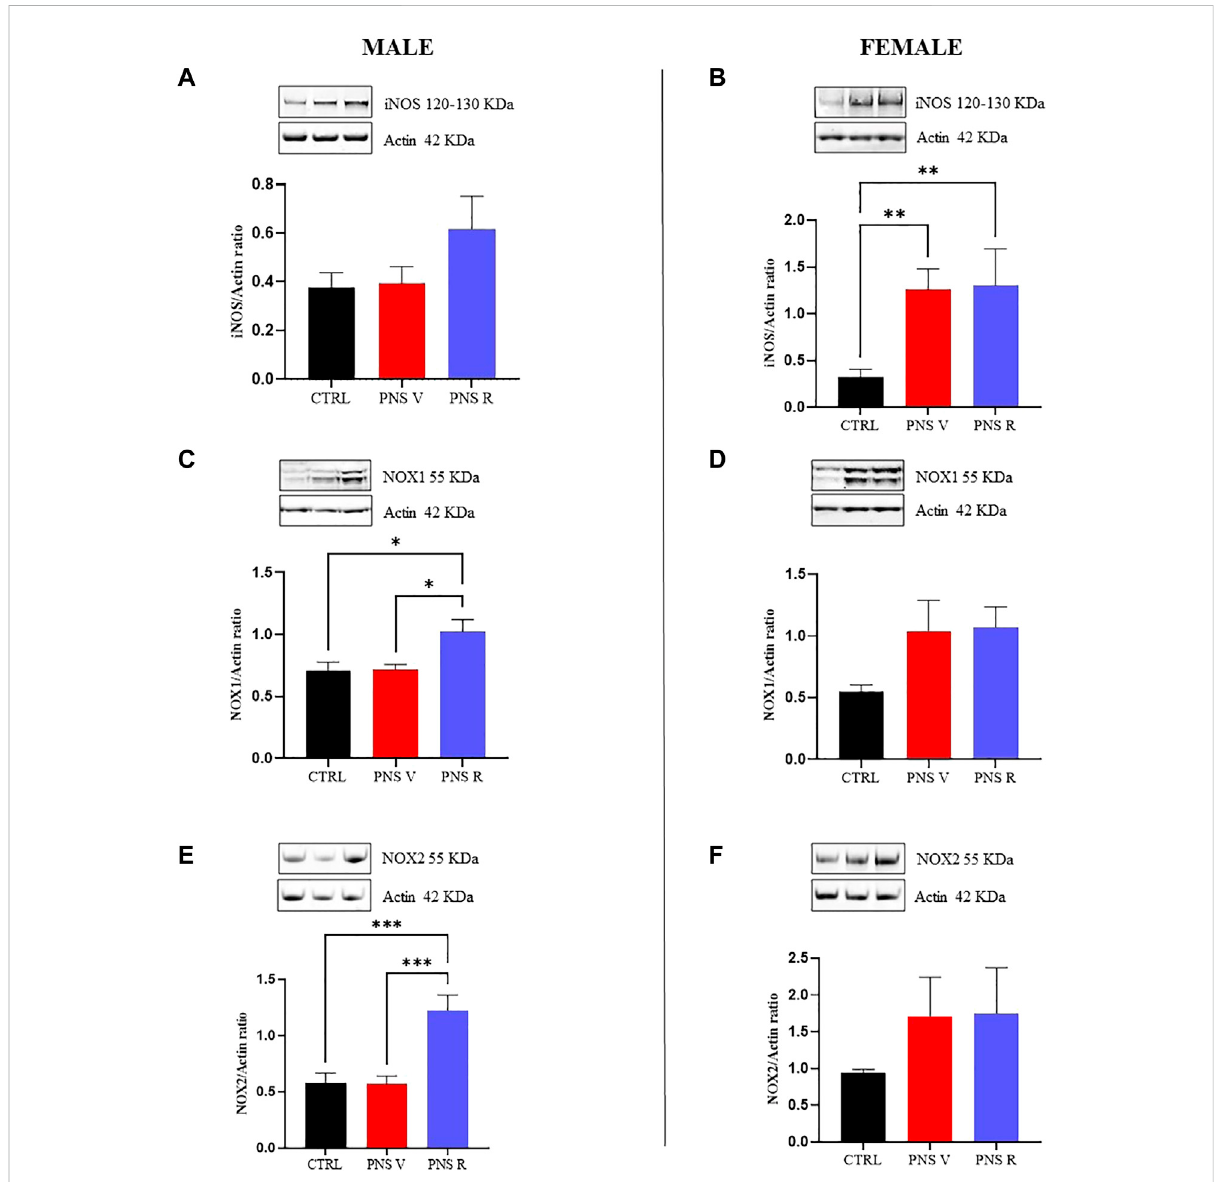
Oxidative stress response in vulnerable and resilient PNS rats. Effects induced by PNS exposure on iNOS, NOX1, and NOX2 expression in total protein extracts from hippocampus of CTRL and PNS rats evaluated by Western Blot analysis. Representative immunoblots and histograms of iNOS (120 kDa – 130 kDa) in CTRL and PNS male (A) and female (B) adolescent rats (** p < 0.01 vs. CTRL). Representative immunoblots and histograms of NOX1 (55 kDa) in CTRL and PNS male (C) (* p < 0.05 vs. CTRL and PNS V) and female (D) adolescent rats. Representative immunoblots and histograms of NOX2 (55 kDa) in CTRL and PNS male (E) (*** p < 0.001 vs. CTRL and PNS V) and female (F) adolescentrats. Densitometric values were normalized against actin used as internal control. All data are shown as mean ± SEM of CTRL male n = 10; PNS V male n = 9; PNS R male n = 5; CTRL female n = 10; PNS V female n = 5; PNS R female n =